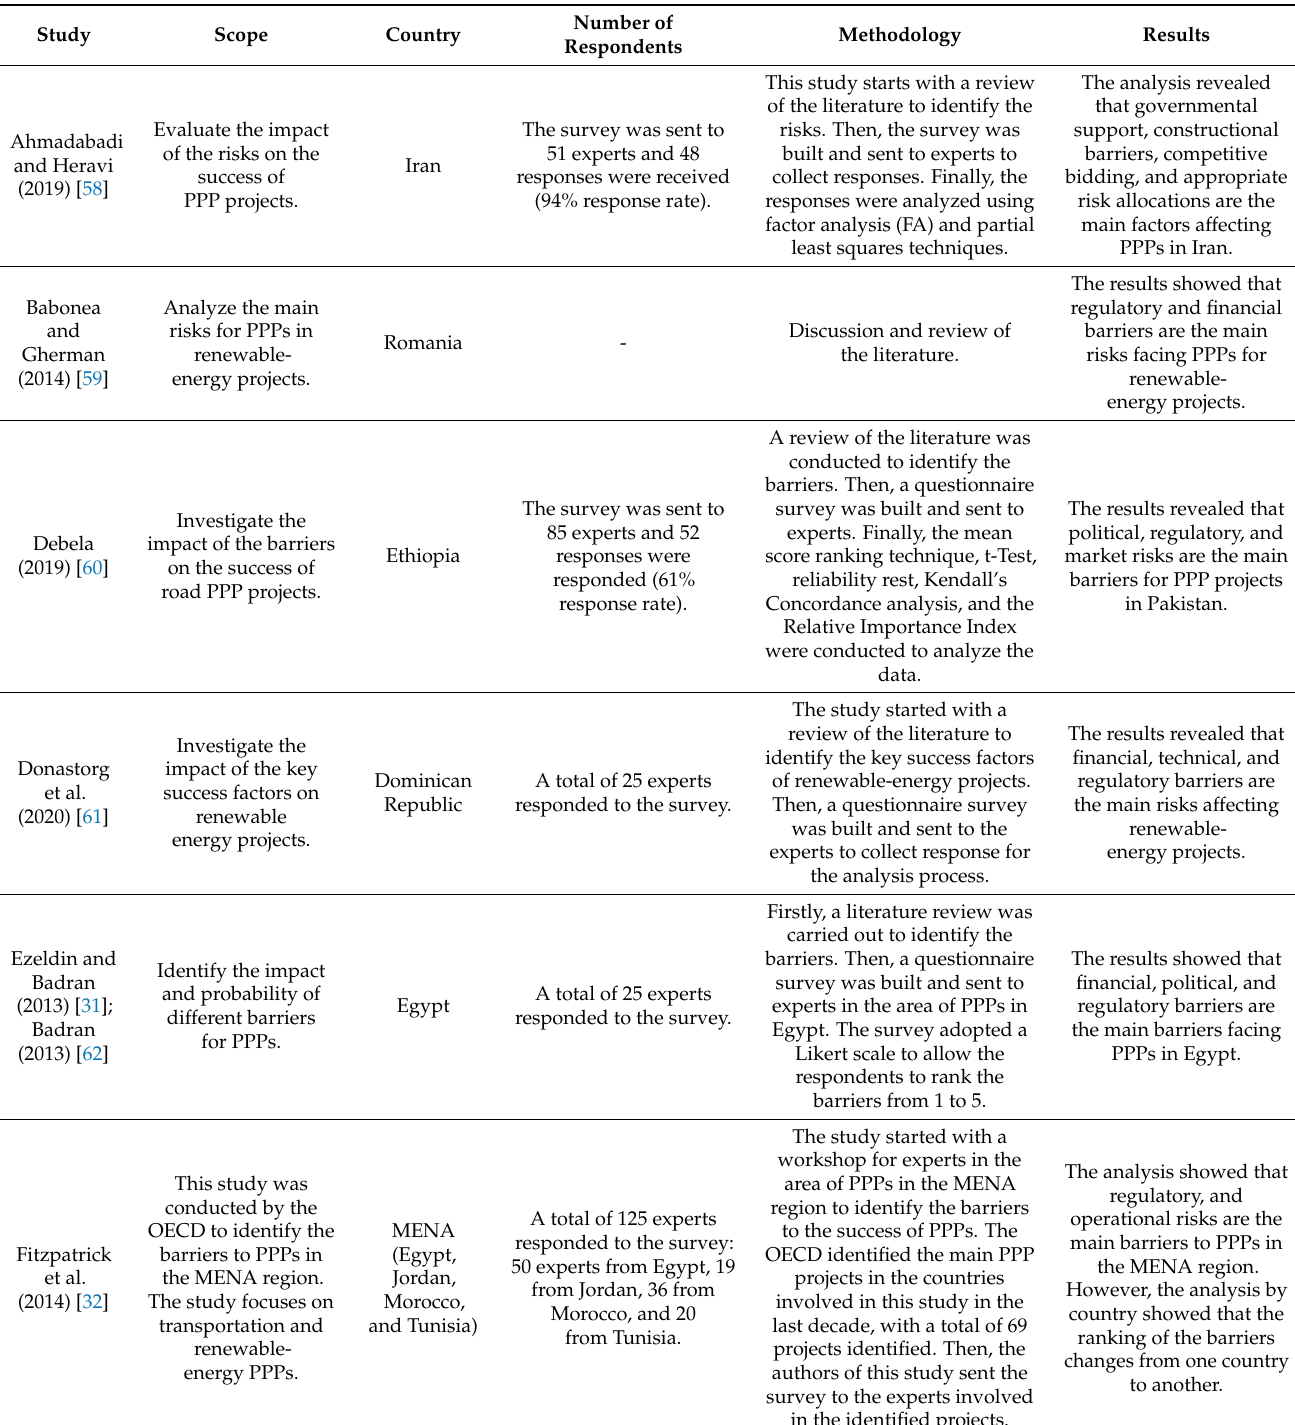
Table A1. Summary of the selected studies that focus on understanding the barriers and key success factors of PPP